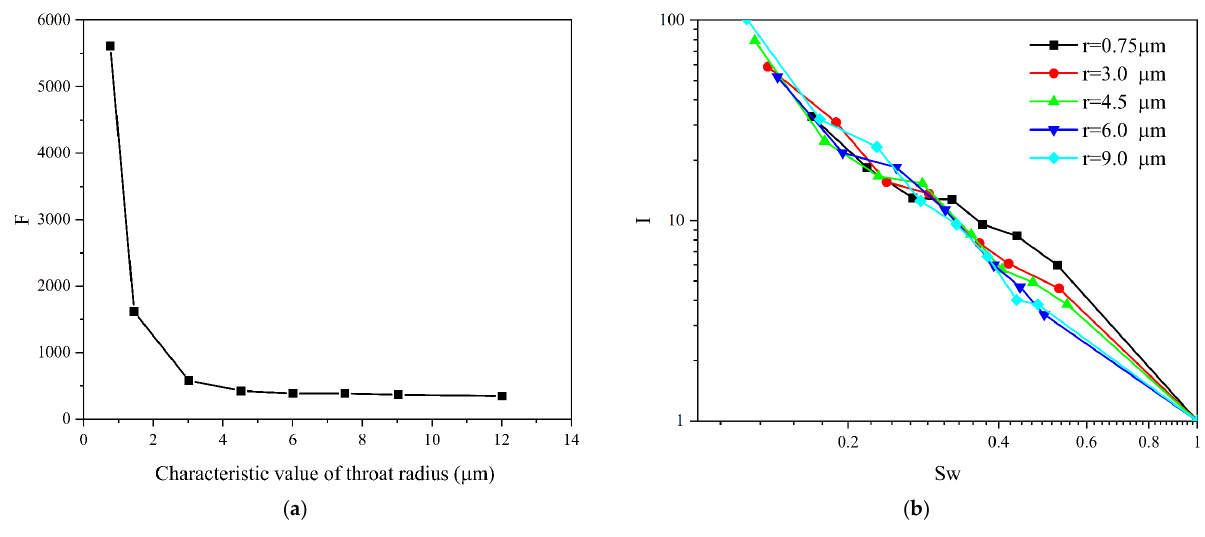
Figure 17. The influence of the characteristic value of the throat radius on the electrical properties of the rock: ( a ) relationship curve between characteristic values of different throat radii and formation factors; ( b ) I-Sw curve under different characteristic values of throat radii.